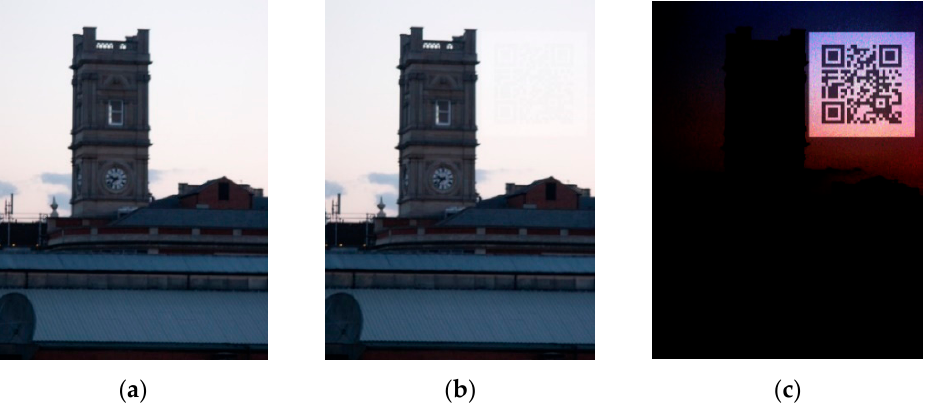
Figure 16. Test image used to evaluate the robustness of the proposed algorithm against image processing attacks. ( a ) Original image, ( b ) watermarked image, PSNR = 46.98 dB, SSIM = 0.9947, NCD = 0.0101, ( c ) exhibited watermark.